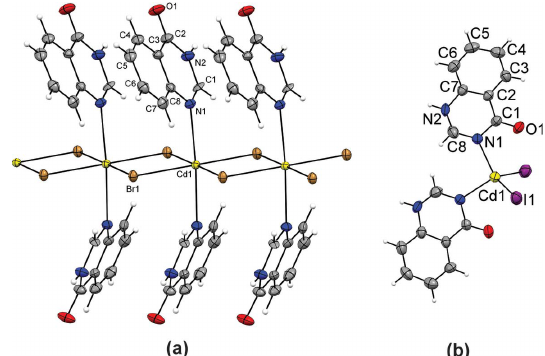
Figure 9 Metal-containing building units ( ORTEP -style plots obtained using Mercury 3.3 ) bearing quinazolinone ligands. ( a ) [CdBr 2 (4-quz) 2 ] n ( 8 ) and ( b ) [CdI 2 (4-quz) 2 ] ( 9 ). The crystal structure of [CdCl 2 (4-quz) 2 ] n ( 7 ) is isostructural with 8 .